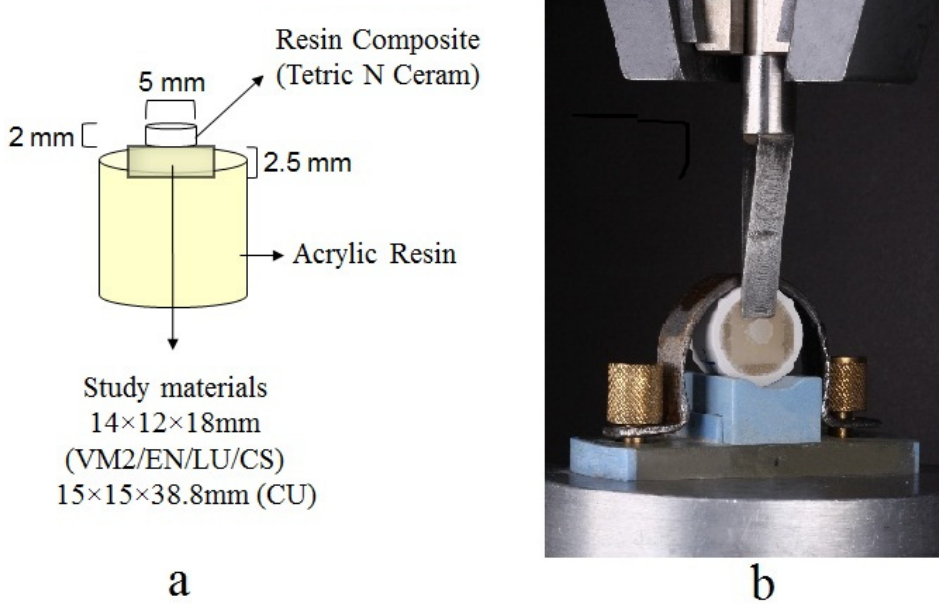
Figure 2. Specimen dimension ( a ), and shear bond strength (SBS) test set-up ( b )